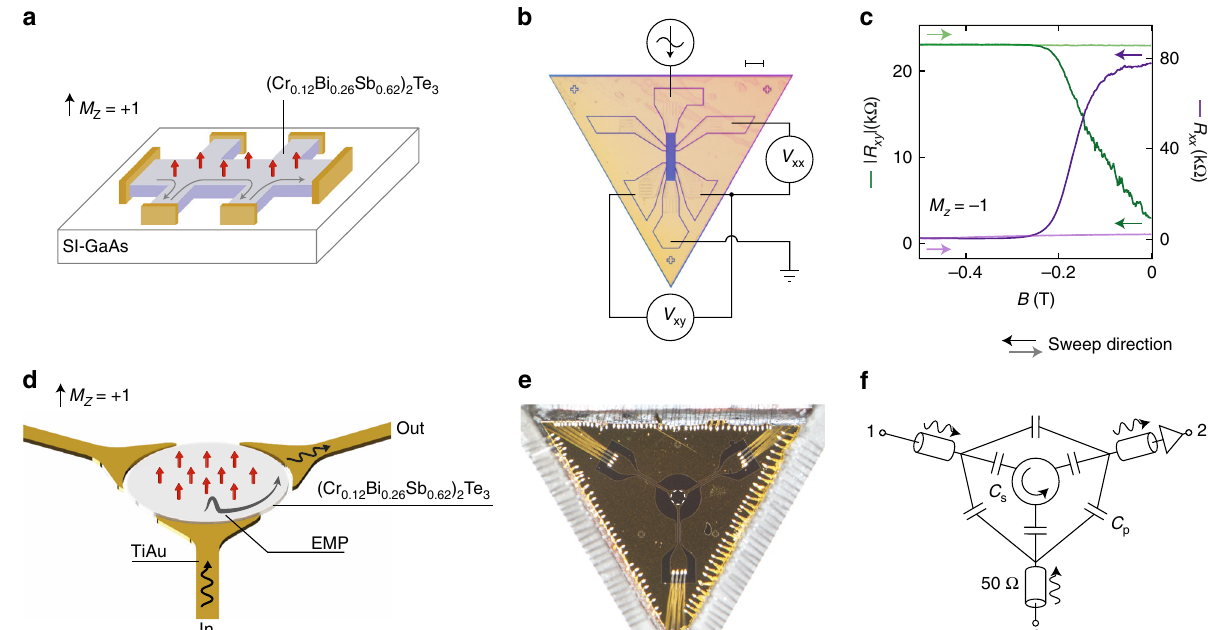
Fig. 1 Experimental setup. a Illustration of the quantum anomalous Hall effect in a three-dimensional topological insulator thin fi lm with ferromagnetic dopants. b Photograph of a Hall bar fabricated on a device with seven quintuple layers of (Cr 0.12 Bi 0.26 Sb 0.62 ) 2 Te 3 grown epitaxially on a GaAs substrate. Scale bar is 100 μ m. Standard lock-in techniques are used to measure the transport properties of the material. c Transverse and longitudinal resistance ( R xy , green, and R xx , purple) as the perpendicular magnetic fi eld is swept out to − 0.5 T (dark coloured lines), and then back to zero fi eld (light shaded lines). d Cartoon of a three-port circulator device with a magnetic topological insulator. e Photograph of the circulator device, scale bar is 500 μ m. f A circuit schematic for the experimental setup. The parasitic capacitances between port electrodes ( C p ) and from the ports to the plasmonic modes ( C s ) are indicated. Port 2 is connected to a low-noise cryo-amp operating at 4 K, allowing measurement of S 21 and S 23 through a common output